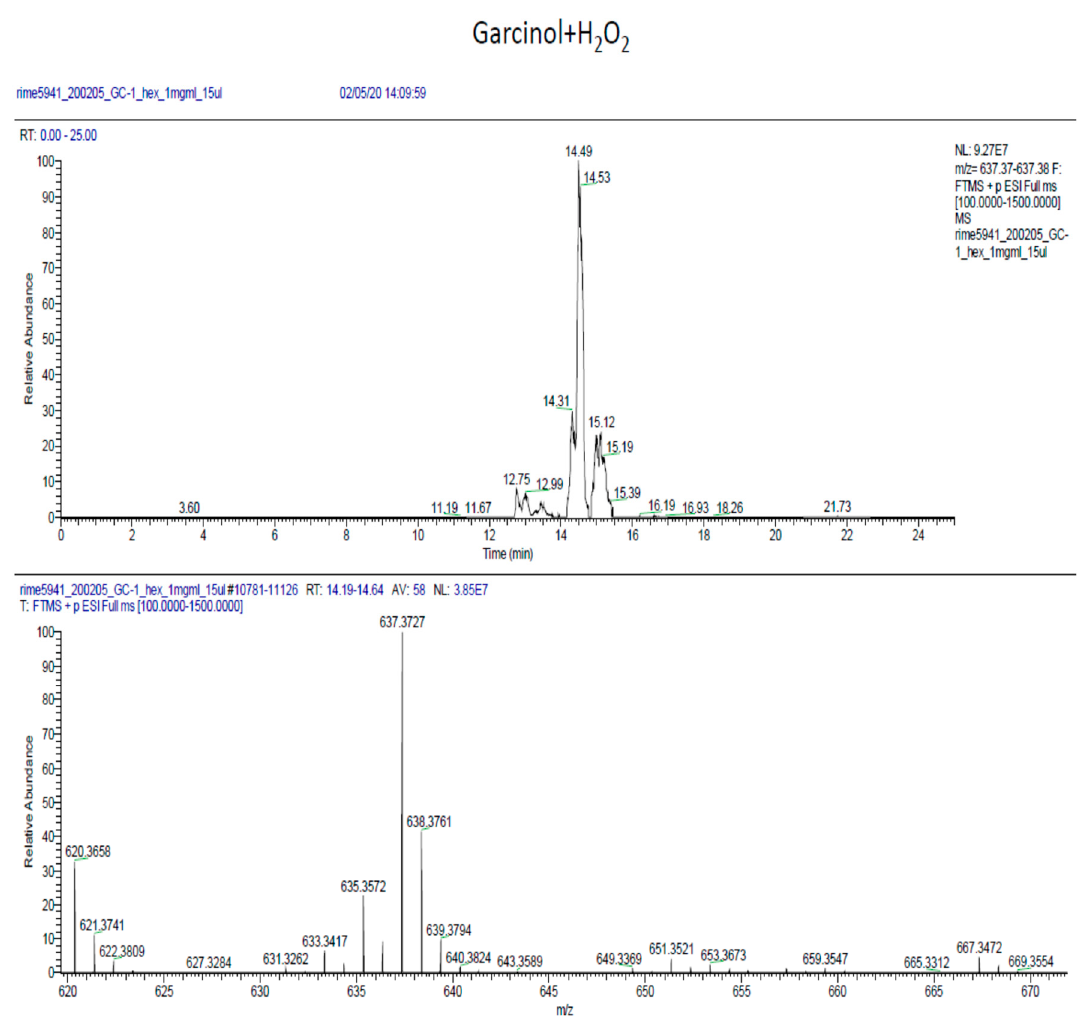
Figure A7. UPLC-MS analysis of the n -hexane extract of G. cambogia indicating the presence of the compound Garcinol+H 2 O 2 .